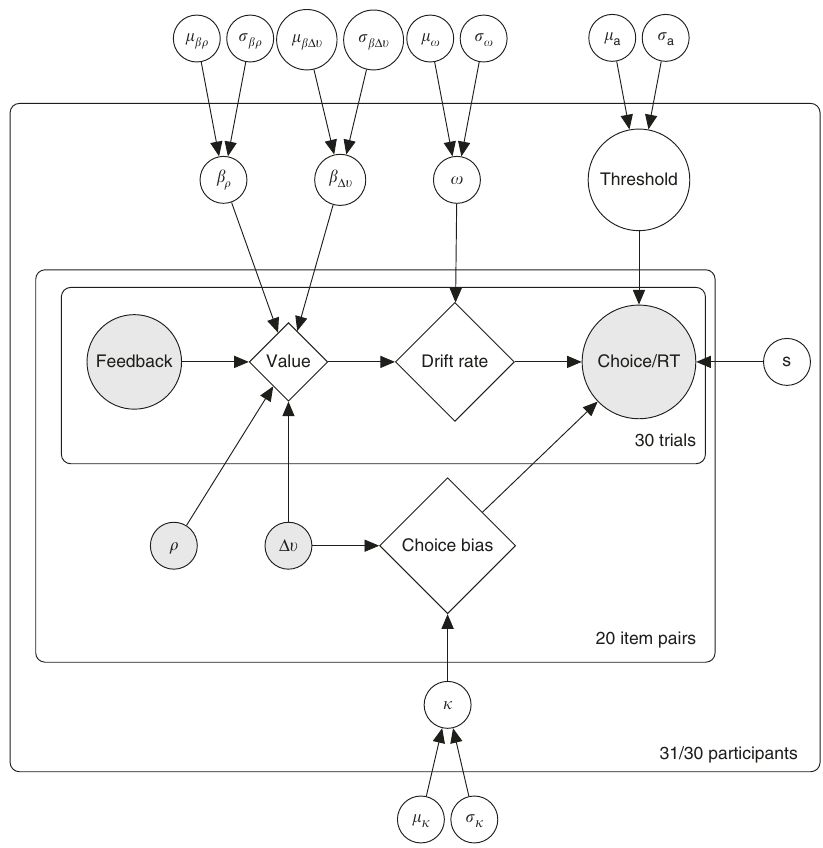
Fig. 5 Graphical schematic representation of the dual in fl uence model with item popularity. Unshaded circular nodes represent unobserved latent parameters that were estimated in the model. Diamond nodes represent variables whose values are fully determined by other nodes, and shaded nodes represent observed data. Except for non-decision time, latent parameters were estimated hierarchically, which assumed that each participant ’ s latent parameter value was the product of a group-level distribution with mean μ and standard deviation σ . β ρ is the in fl uence of item popularity on the prior; β Δ v is the in fl uence of preference on the prior; ω is the weighting term for translating learned values into a drift rate; ρ is the relative popularity of the item; Δ v is the participant ’ s relative preference for the item; κ is the in fl uence of preference on choice bias; and s is the non-decision